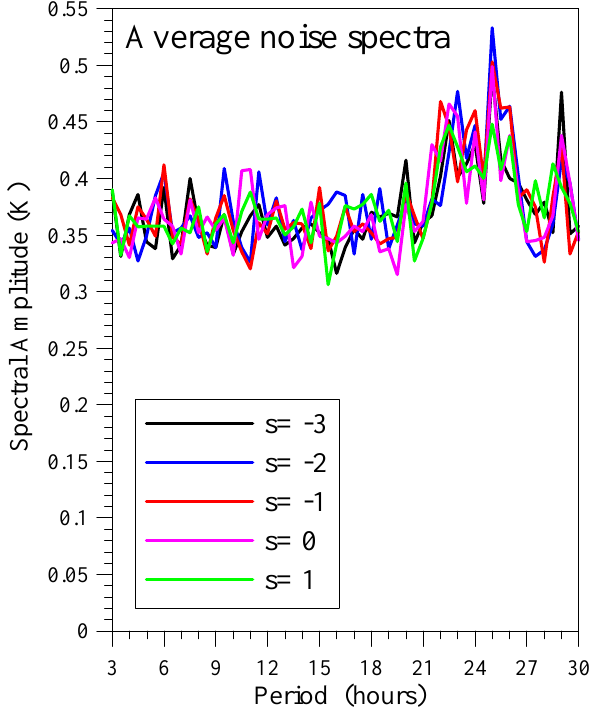
Figure 2a Fig. 2a. Average reference noise spectra for different zonal wavenumber calculated for December/January at latitude 40 ◦ N and altitude of 40km (for details see the text); black color for zonal wavenumber s = − 2; blue for s = − 2; red for s = − 1; magenta for s=0 and green for s